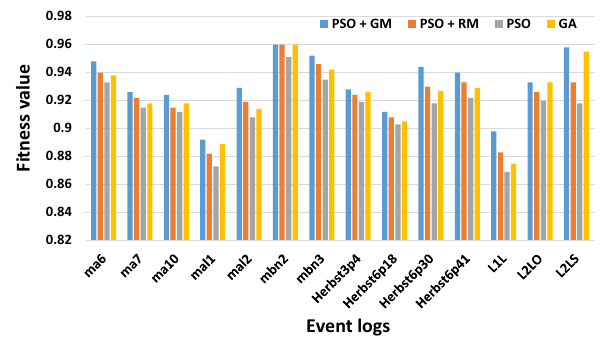
Fig. 5 Fitness value achieved by four different methods 2 https:// svn. win. tue. nl/ repos/ prom/ DataS ets/ Genet icMin